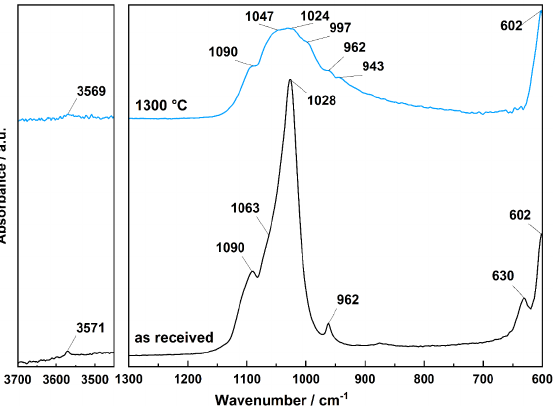
Figure 6. ATR-FTIR spectra of as received CDHA ( bottom ) and corresponding spectra after the material sintering at 1300 °C ( top ). 2.4. Surface Morphology of Scaffolds Sintered at Elevated Temperatures The morphology of the scaffolds before and after sintering observed by SEM is shown in Figure 7. The scaffolds printed from composite filament sintered at elevated tempera- tures of 1200, 1300, and 1400 °C revealed linear shrinkage when compared to the green body, corresponding to values ranging from ~30 to 33%.